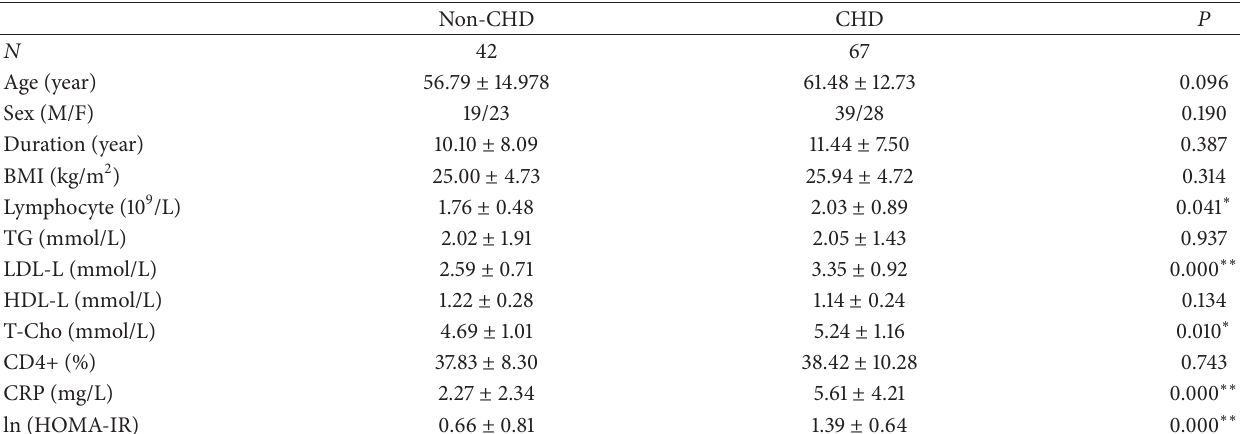
Table 1: Demographic characteristics of